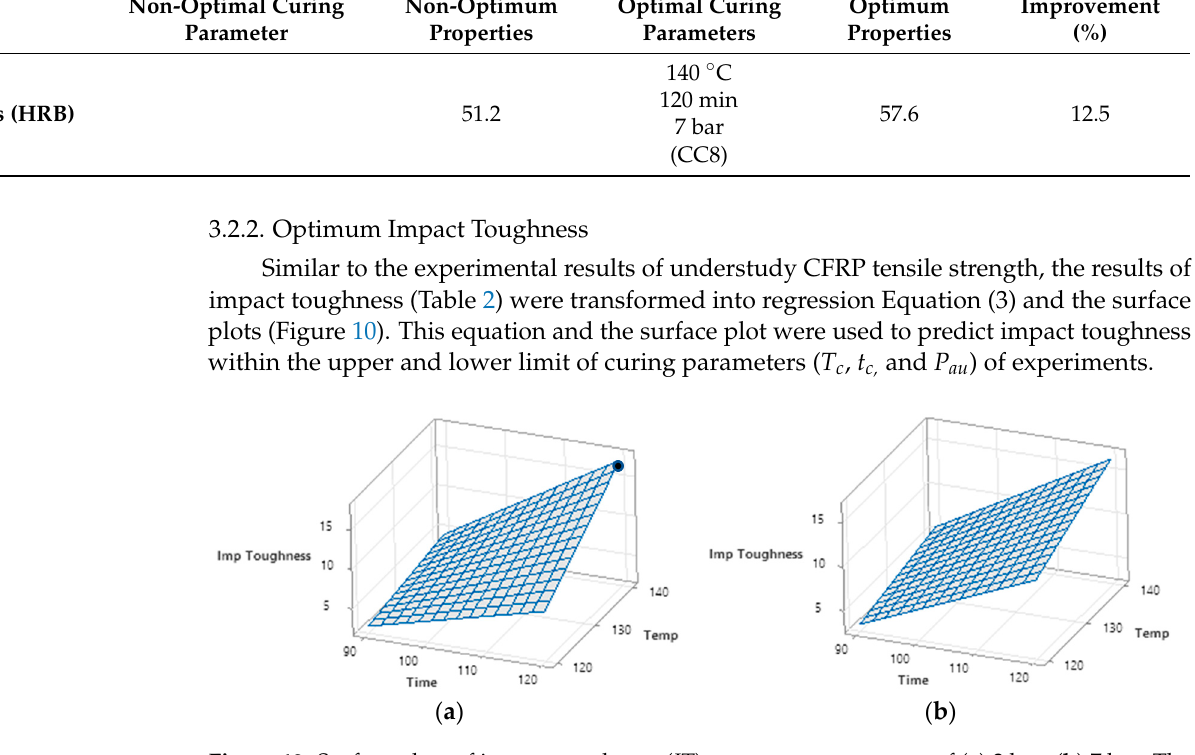
Figure 10. Surface plots of impact toughness ( IT ) at a constant pressure of ( a ) 3 bar; ( b ) 7 bar. The optimum impact toughness was observed at CC4 (140 °C, 120 min, 3 bar), represented by a black dot.